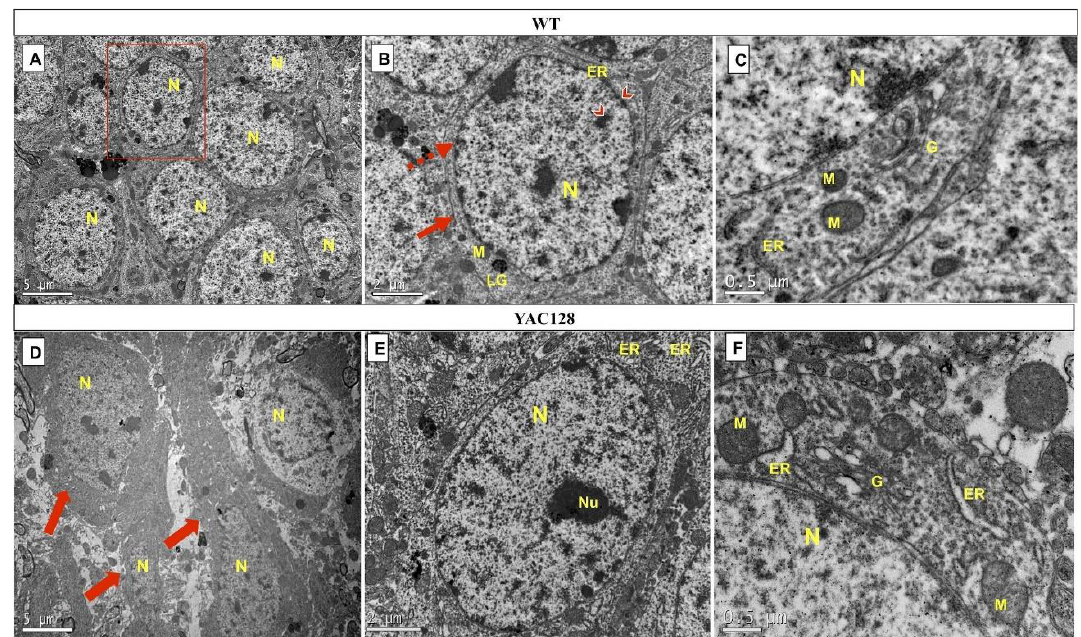
Figure 6. Ultrastructural analysis of DG granular neurons from late symptomatic YAC128 mice and age-matched WT controls. Granule cells bodies from WT mice can be seen in the upper panel ( A – C ) compared with YAC128 mice in the bottom panel ( D – F ). Higher magnification view of the boxed area in ( A ), representing a typical WT DG granule neuron with preserved nuclear (dashed arrow) and plasma (straight arrow) membranes. Note the heterochromatin margination in the nuclear membrane and some clusters dispersed in the nucleus (red arrow) ( B ). WT DG granule neuron with normal shape and normal electron density of the cytoplasmic and nuclear membrane and intact cytoplasmic organelles (ER, M, and G) ( C ). In contrast, YAC128 DG granule cells are more electron-dense (both with regards to their cytoplasm and nuclei), as evidenced by the presence of dark neurons, which exhibit an irregular outline and shrunken nucleus and cytoplasm (open arrows) ( D ). YAC128 intact DG granule cells with a conserved nucleus and cytoplasmic shape, but dilated organelles can also be observed ( E ). Dilated ER and enlarged Golgi cisternae were seen, although mitochondria appear normal or show a mild crest loss ( F ). Abbreviations: G, Golgi apparatus; LG, lipofuscin granules; M, mitochondria; N, nucleus; ER, rough endoplasmic reticulum (scale bar = 5 µm ( A , D ), 2 µm ( B , E ), and 0.5 µm ( C , F )).